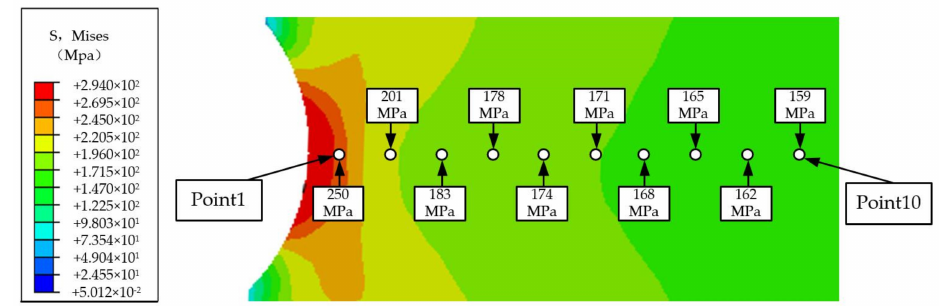
Figure 18. The finite element analysis (FEA) stress distribution near the arc notch and the stresses at measuring